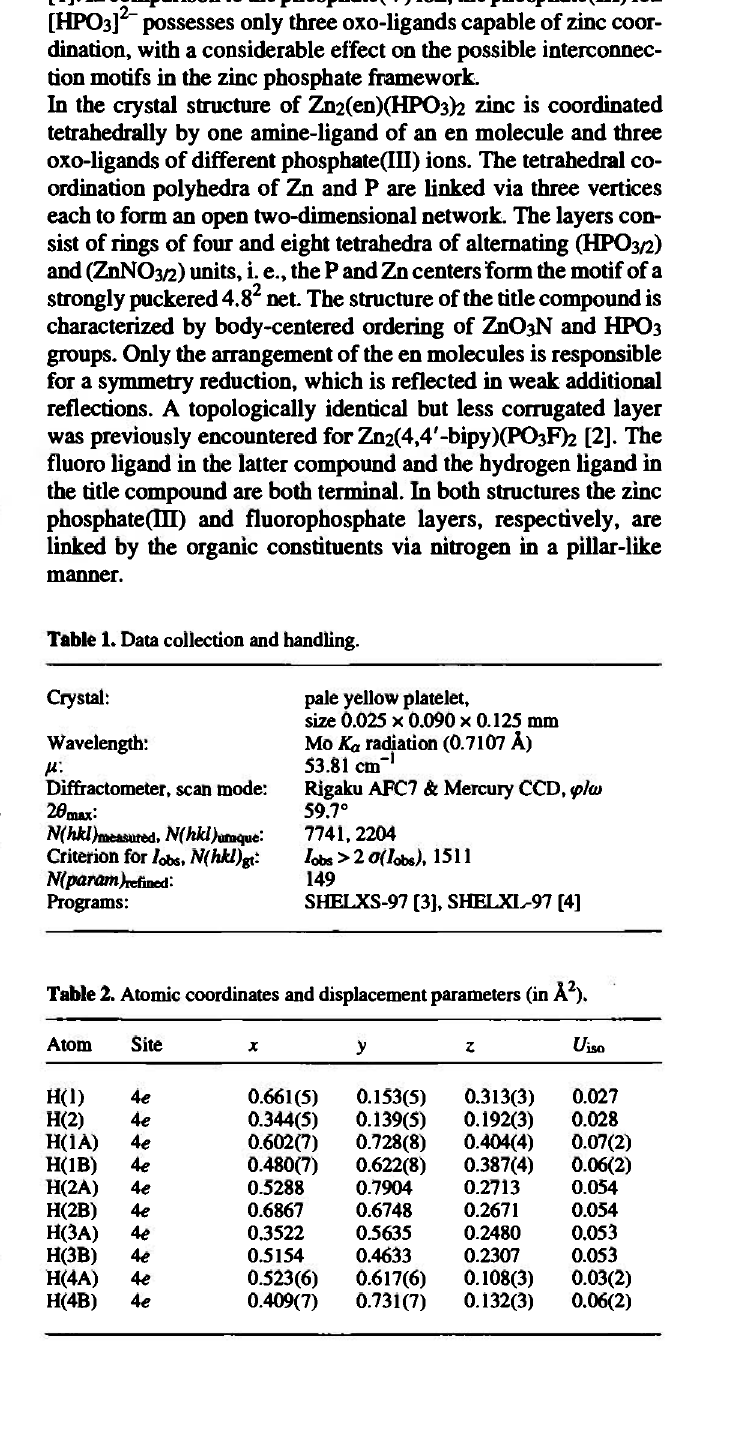
Table 2. Atomic coordinates and displacement parameters (in A 2